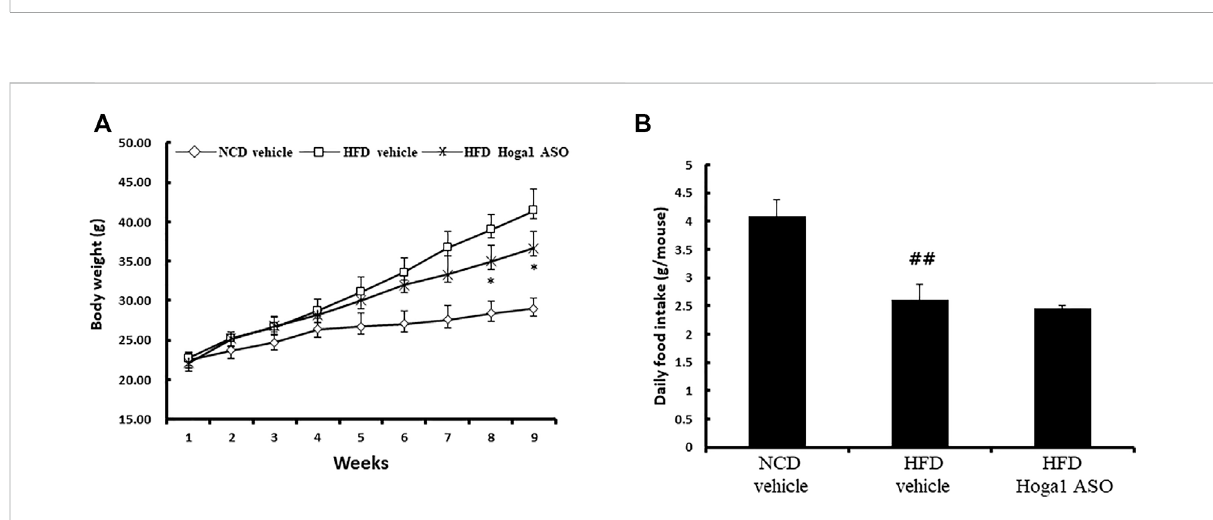
FIGURE 5 Reversible weight loss in diet-induced obese mice due to Hoga1 knockdown. Body weight gain (A) and food intake (B) in NCD and HFD mice treatedwithscrambledcontrolASOor Hoga1 ASOweremeasuredfromsixmicepergroup( ## p < 0.01indicatesasigni fi